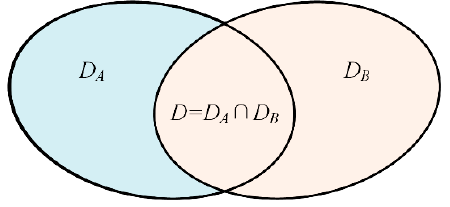
Figure 3. Two different source domain datasets.